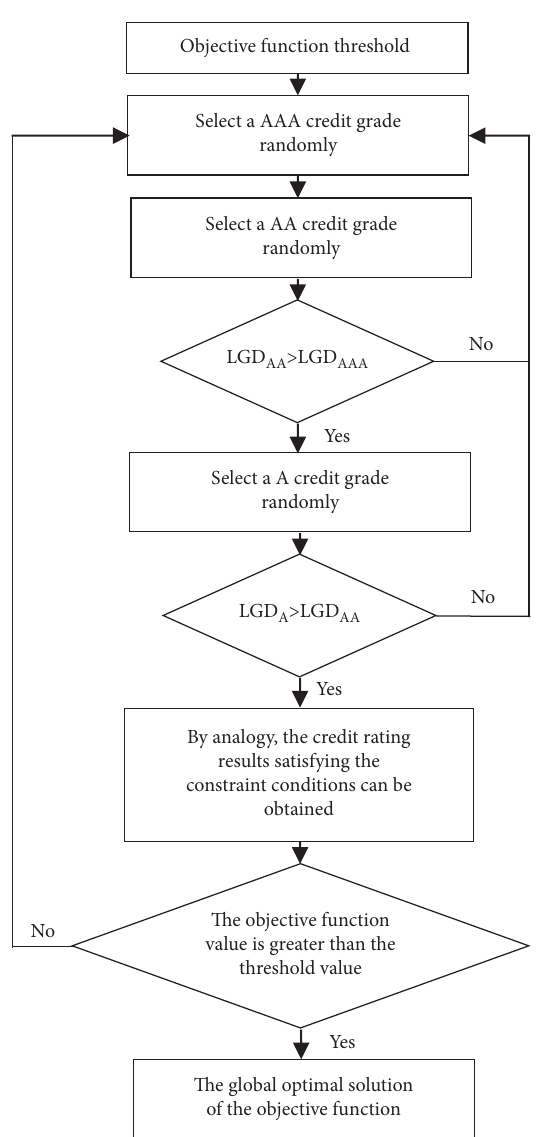
Figure 2: Flowchart of solving credit rating